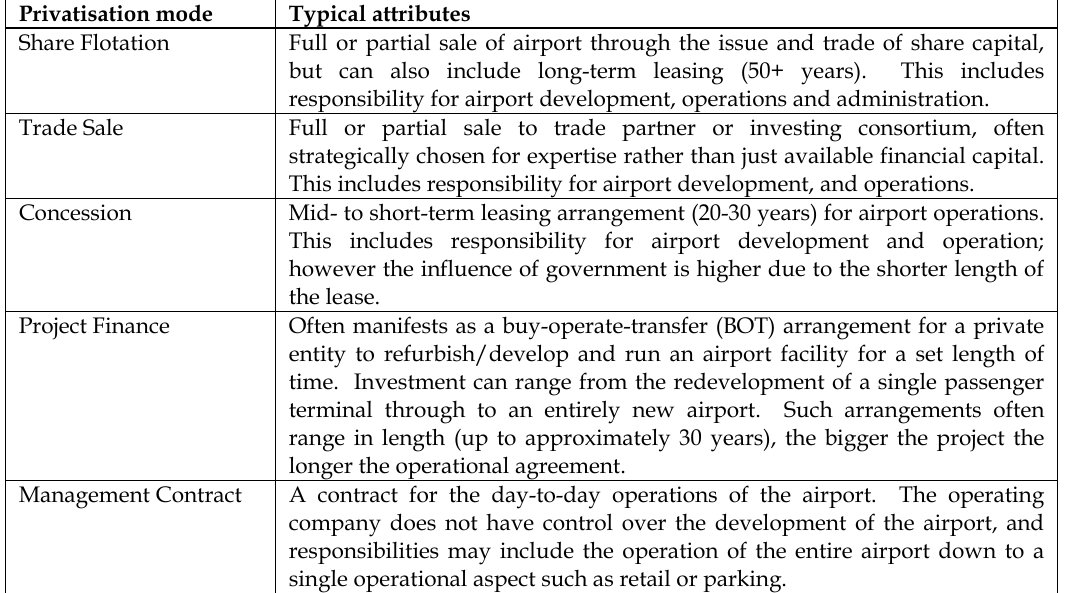
Table 1. Graham’s (2003) five modes of